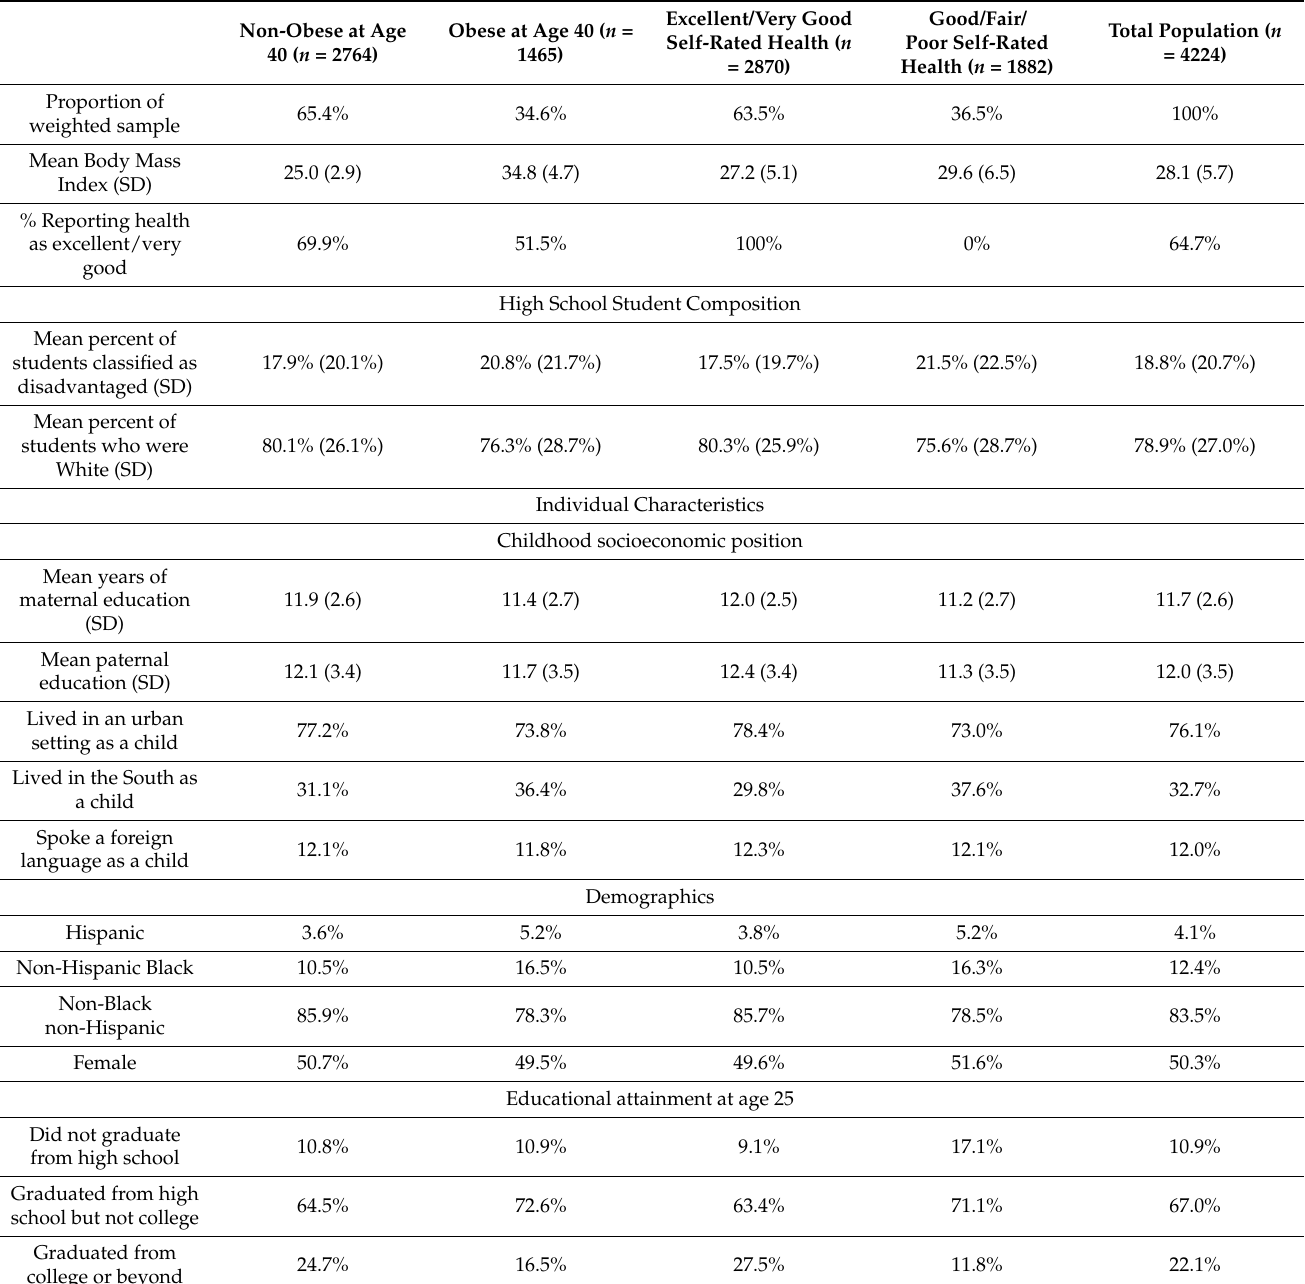
For the relationship between student racial/ethnic composition and self-rated health, there was no significant interaction by individual race/ethnicity ( p = 0.51) or maternal education ( p = 0.22). Table 1. Descriptive statistics, presented for the total population, by self-rated health status and obesity status. Excellent/Very Good Good/Fair/ Non-Obese at Age Obese at Age 40 ( n = Total Population ( n Self-Rated Health ( n Poor Self-Rated 40 ( n = 2764) 1465) = = 2870) Health ( n = 1882)